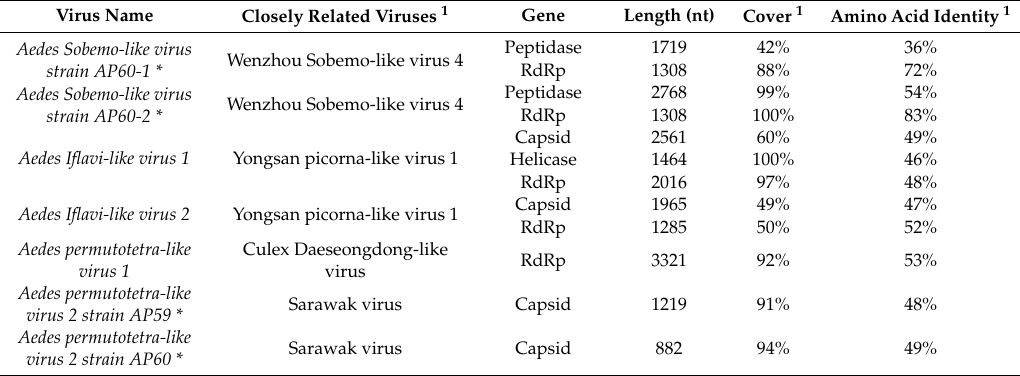
Table 1. Amino acid similarity of sequences identified in metagenomics analysis from Ae. aegypti